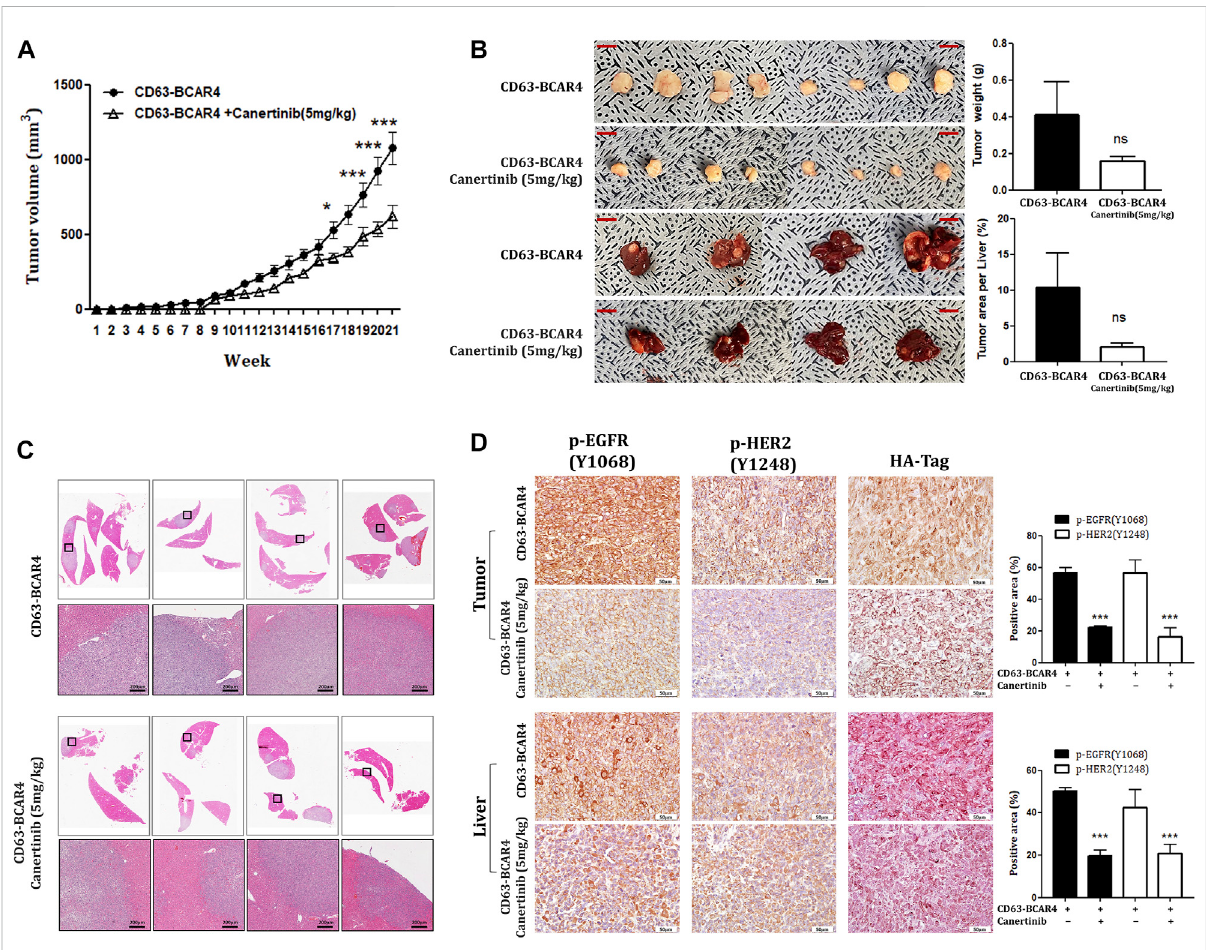
FIGURE 5 Effects ofcanertinib ontumorgrowth and metastasisinthemouse xenograft model. (A) Tumor growth wasassessedover20 weeks in NOG mice transplantedwithCD63-BCAR4overexpressingBEAS-2Bcellswithorwithoutcanertinibtreatment.Tumorvolumesareshownasmeans±SEM( n =8in canertinib treated group, n = 12 in untreated group). Statistical signi fi cances are marked with * ( p < 0.05), and *** ( p < 0.0005). (B) Resected tumor specimens and livers from the subcutaneously transplanted mice. Tumor weight and metastatic tumor area per liver were compared. ns, not signi fi cant. (C) H&E-stained tissuesfrom metastatictumors intheliversofxenograftmice. (D) ImmunohistochemistryofphosphorylatedEGFR[p-EGFR (Y1068)], phosphorylated HER2 [p-HER2 (Y1248)], and HA tag proteins in tumor and liver sections from xenografted mice. The expression levels of phosphorylated proteins were compared by semi-quantitative analysis of IHC signals. Statistical signi fi cances are marked with *** ( p <